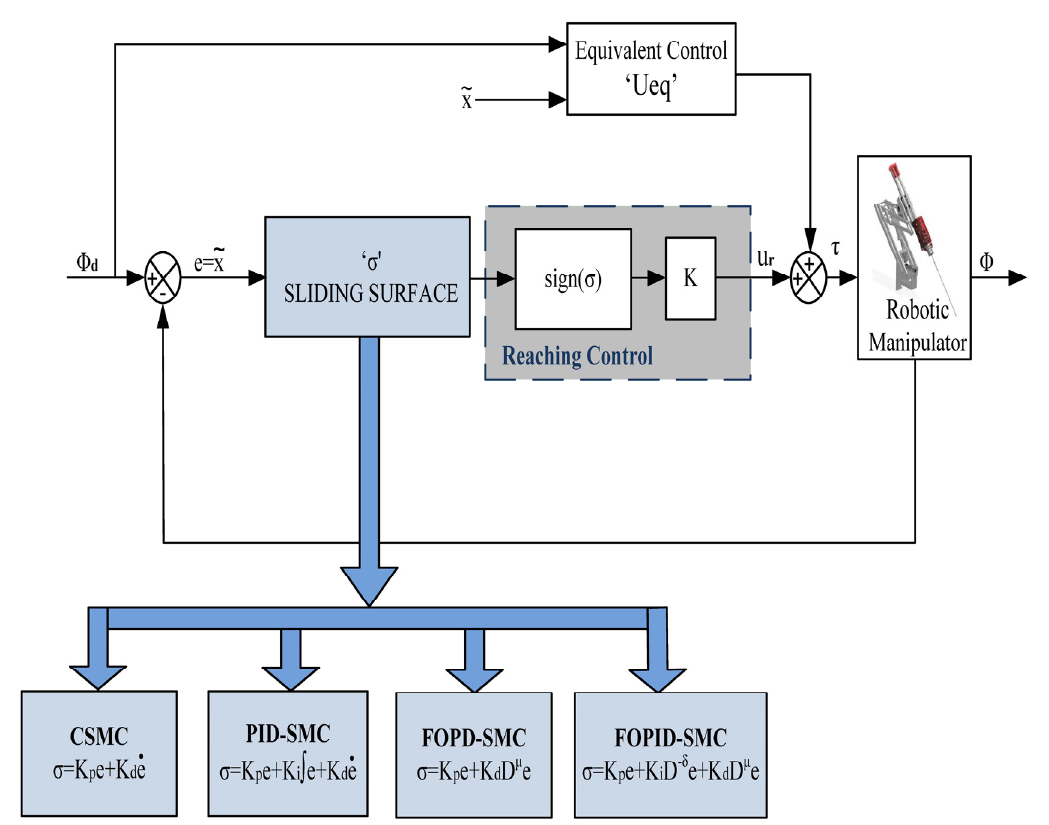
Figure 3. Conventional SMC controllers for surgical manipulators.